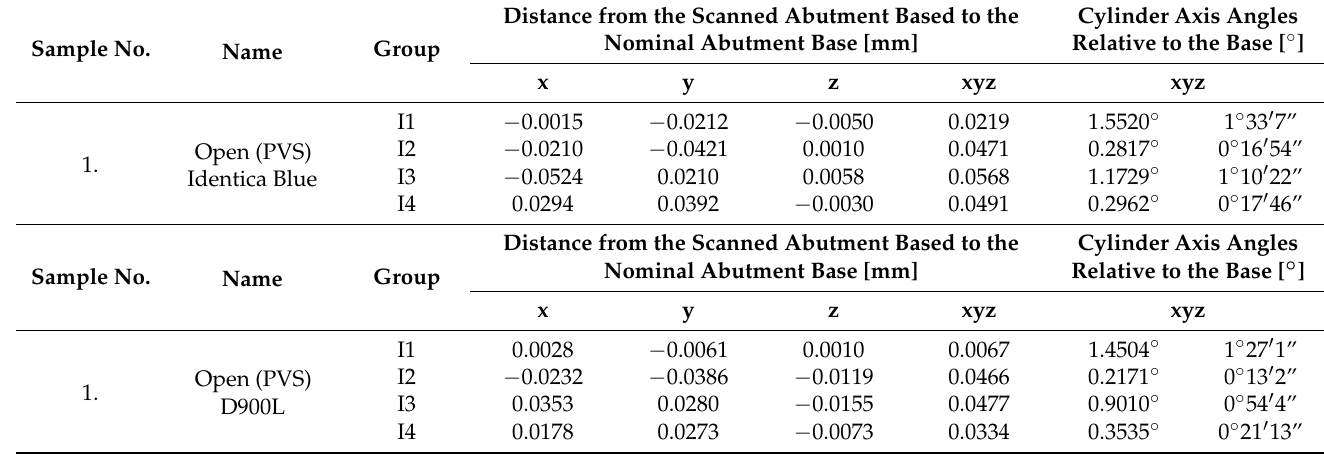
Table 3. Deviation analysis results for the open impression method with PVS material (sample no. 1) for angulated implants (I1 and I2) and parallel implants (I3 and I4) using both 3D